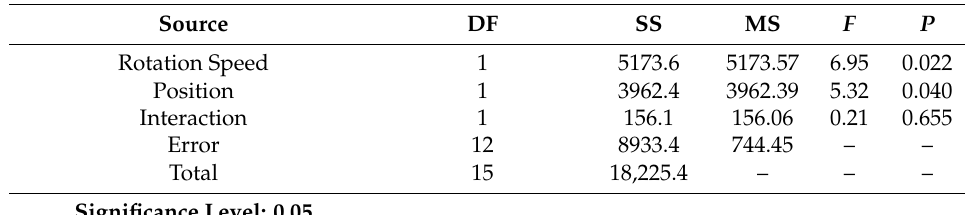
Table 8. Surface Plot of UTS vs. rotation speed ( n ) and position.